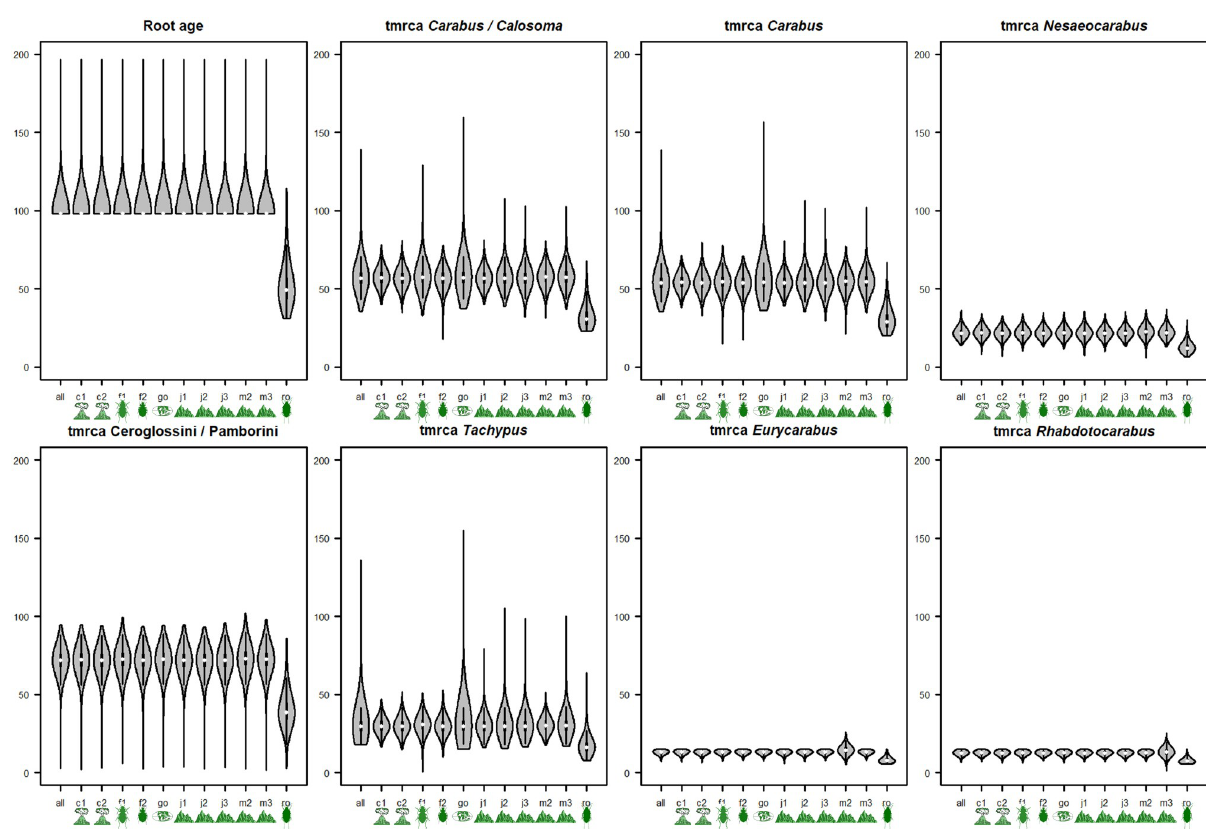
Fig 2. Violin plots of different TMRCA in relation to individual calibration points. The plots depict the mean (white dots), standard deviation (sd; black bars), 2 � sd (black line), and density distribution (grey shape) of a clade’s age as obtained from the calibration analyses in Fig 1 for each major clade in relation to exclusion of individual calibration points. The x-axis denotes (letter) and depicts (icon) the respectively excluded calibration points in the respective analysis.